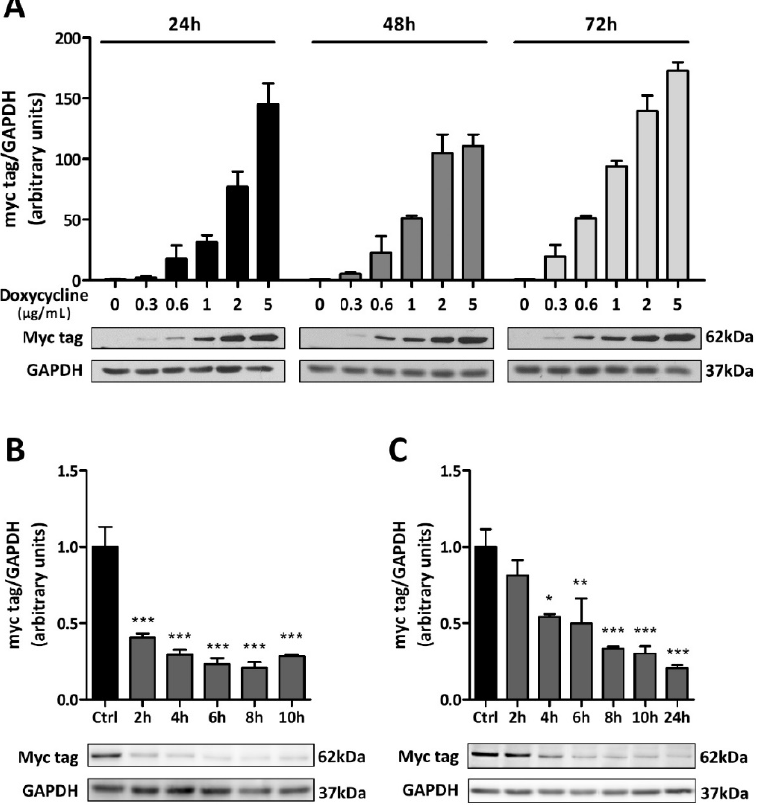
Figure 2. Validation of the inducible system. ( A ) C6-rtTA-AMPK-DN cells were exposed to increasing concentrations of DOX for 24, 48, and 72 h and the expression of the myc-tagged α 1 DN was evaluated by immunoblotting. ( B , C ) To assess for the stability of the α 1 DN, cells were either exposed to 10 µg/mL of cycloheximide ( B ), or the culture medium was renewed to remove DOX after 24 h ( C ). Cells were collected every 2 h, and the expression of the myc-tagged α 1 DN was evaluated by immunoblotting. Histograms show means ± SEM normalized to GAPDH expression. Blots shown are representative of three independent experiments. Blots in panel C were cropped to remove nonessential experimental conditions. Statistical analyses were performed by one-way ANOVA followed by Dunnett’s multiple comparison test (* p < 0.05, ** p < 0.01, *** p <